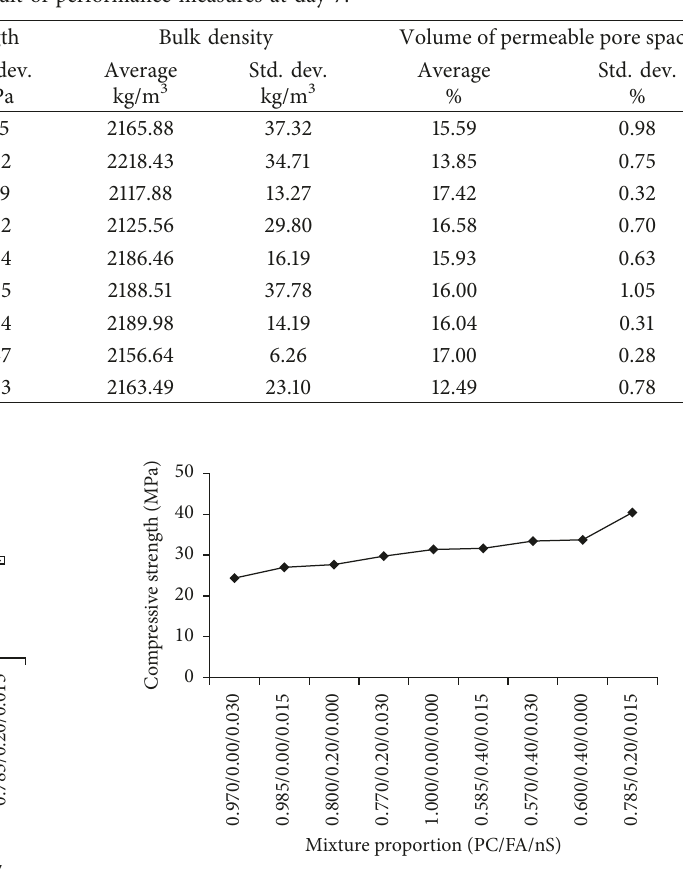
Figure 2: Mean compressive strengths measured at aging day 7.